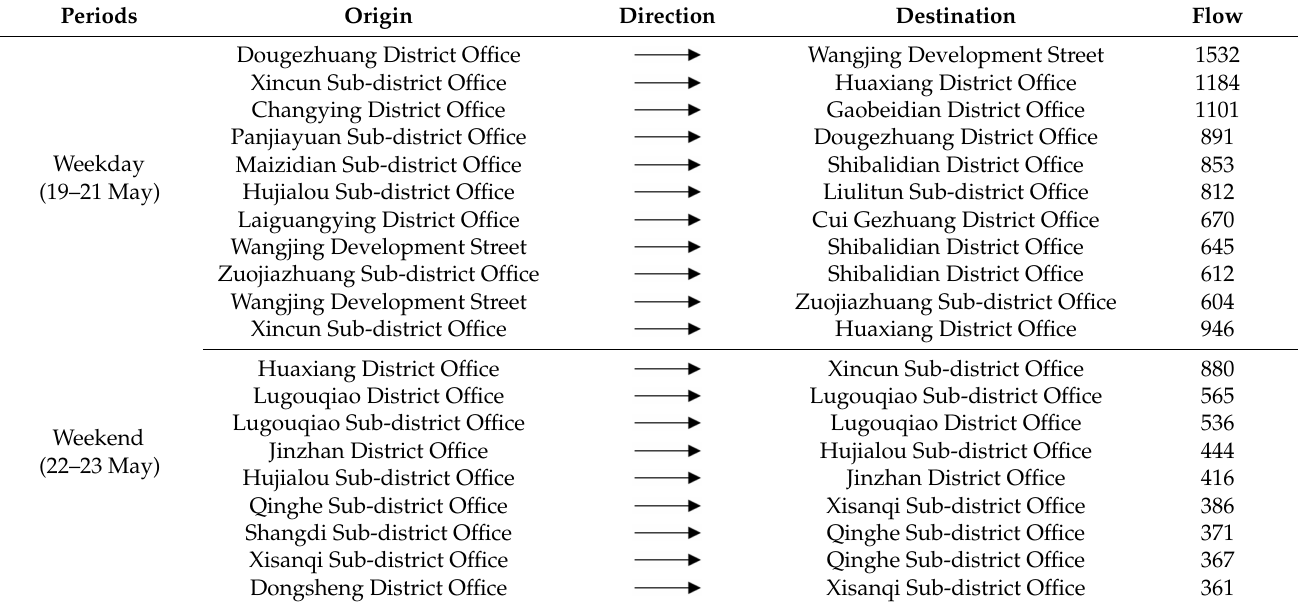
Table 4. Travel volume ranking.